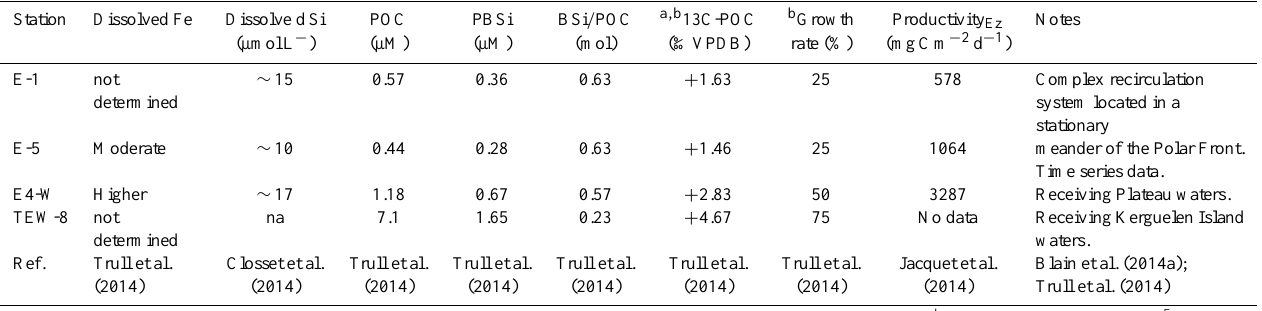
Table 1. Description of sampling stations and associated biogeochemical characteristics.